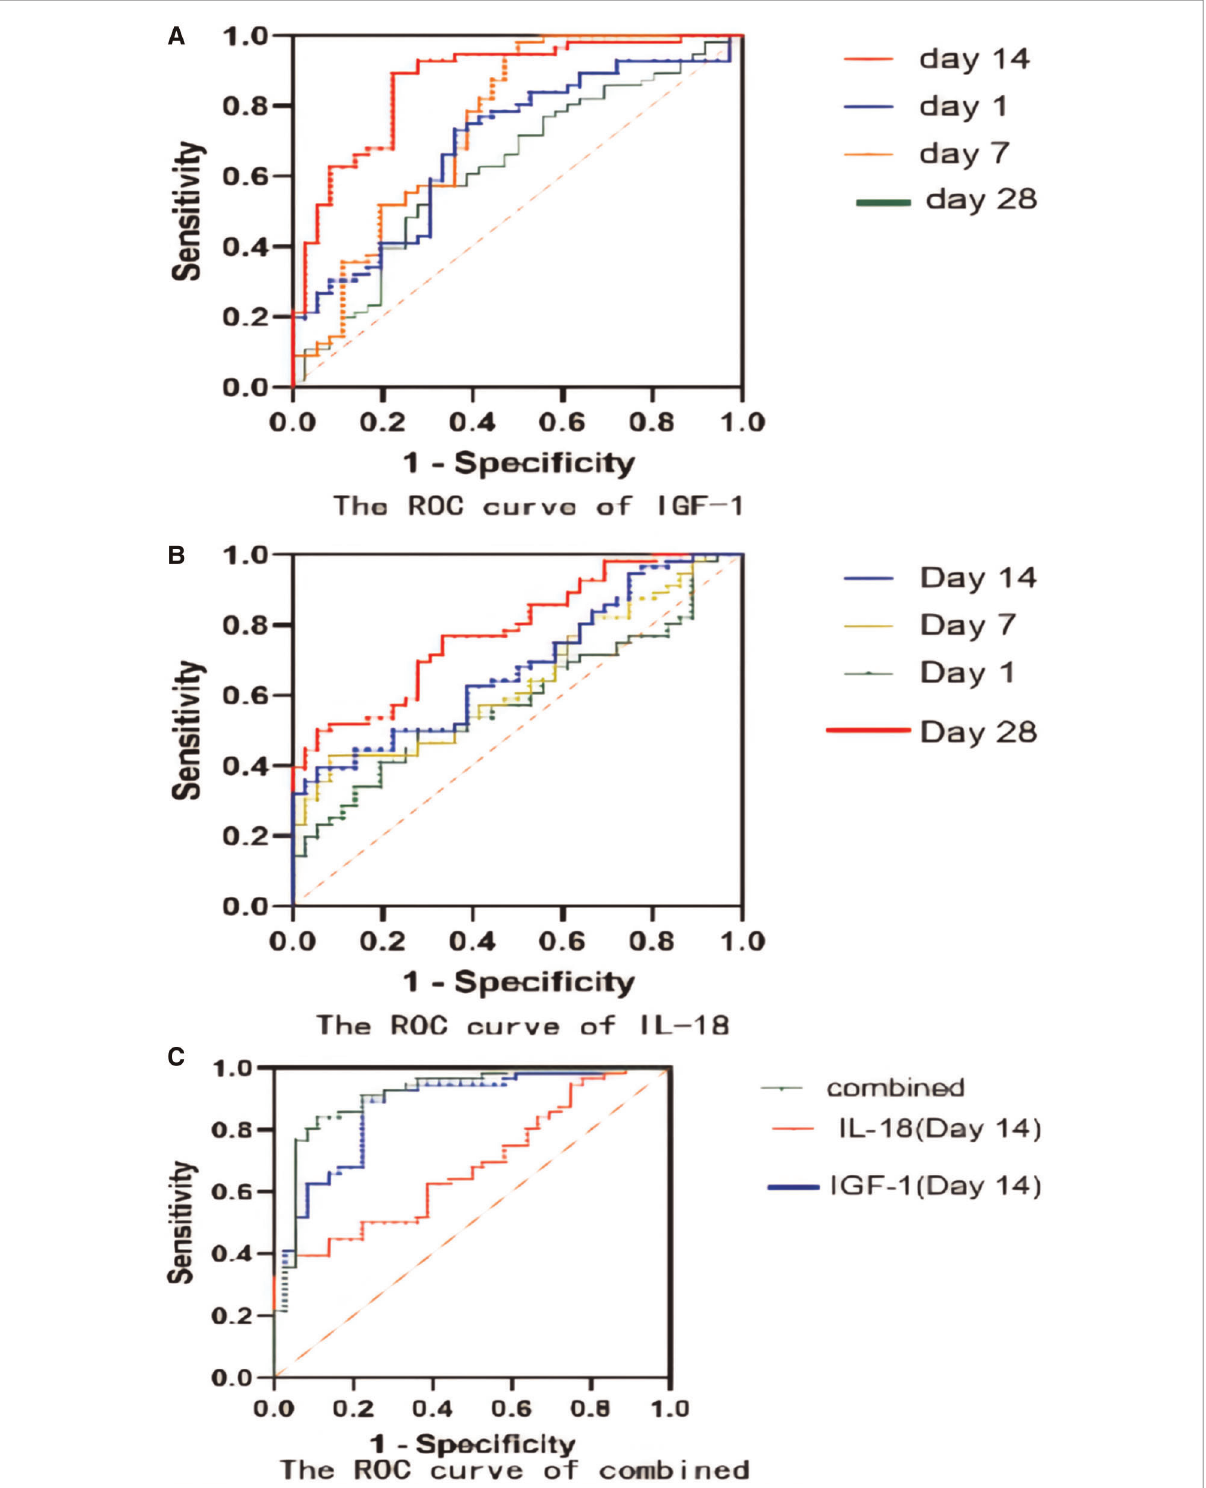
FIGURE 6 ( A ) The ROC curve of IGF-1 for BPD prediction; ( B ) The ROC curve of IL-18 for BPD prediction; ( C ) The ROC curve of IGF-1 combined with IL-18 for BPD